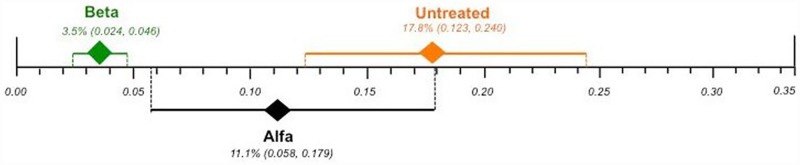
Comparison of the plotted proportional meta-analysis, according to ERT regimens, for cerebrovascular complications.Effect differences were seen due to the non-overlap of the 95% confidence intervals favoring the use of agalsidase beta compared to both untreated patients and agalsidase alfa, as their CIs did not overlap. There was no statistically significance difference between agalsidase alfa and untreated patients, as their CIs overlapped.